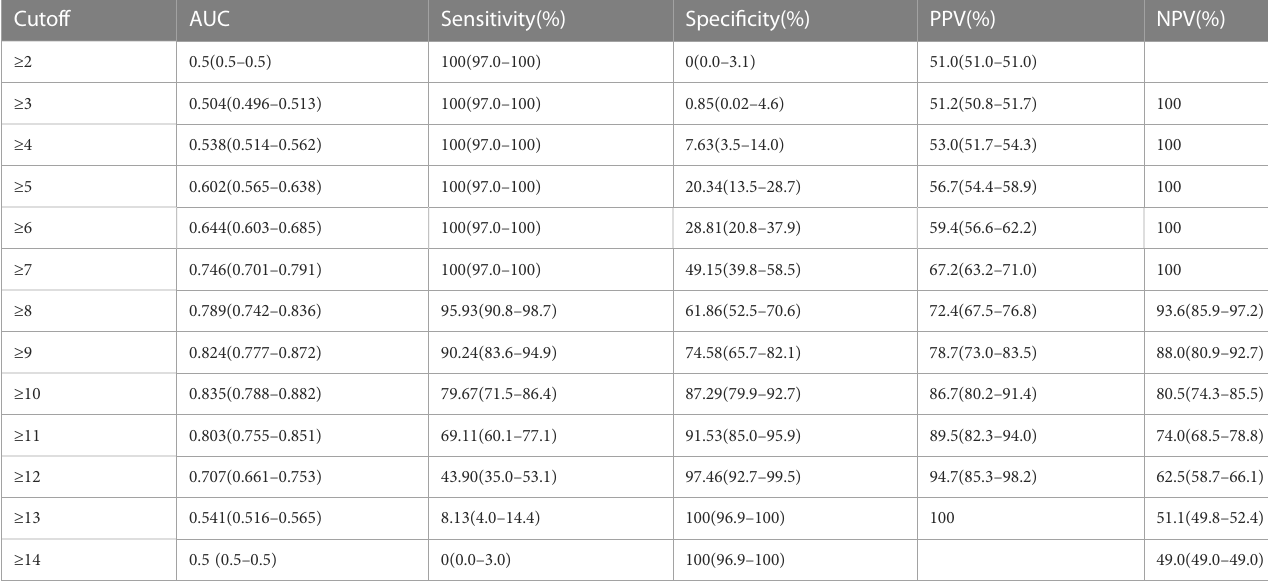
TABLE 3 Diagnostic performance of the diagnostic score model with different cutoffs for